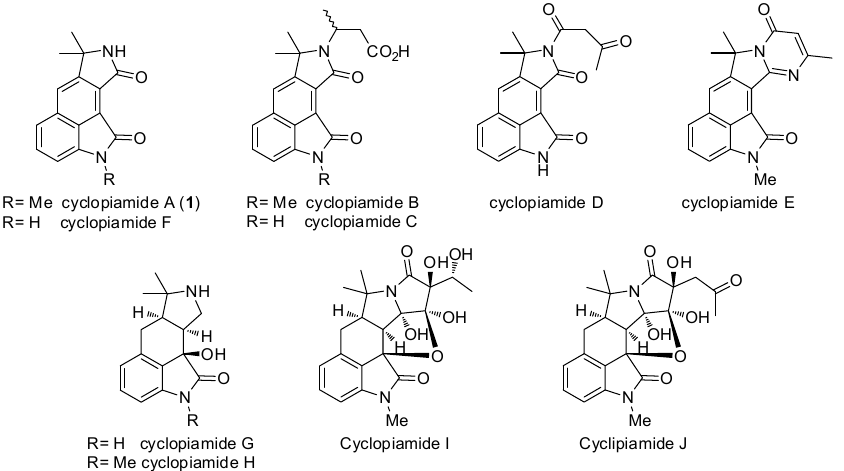
Figure 1. Cyclopiamide A ( 1 ) and its derivatives.